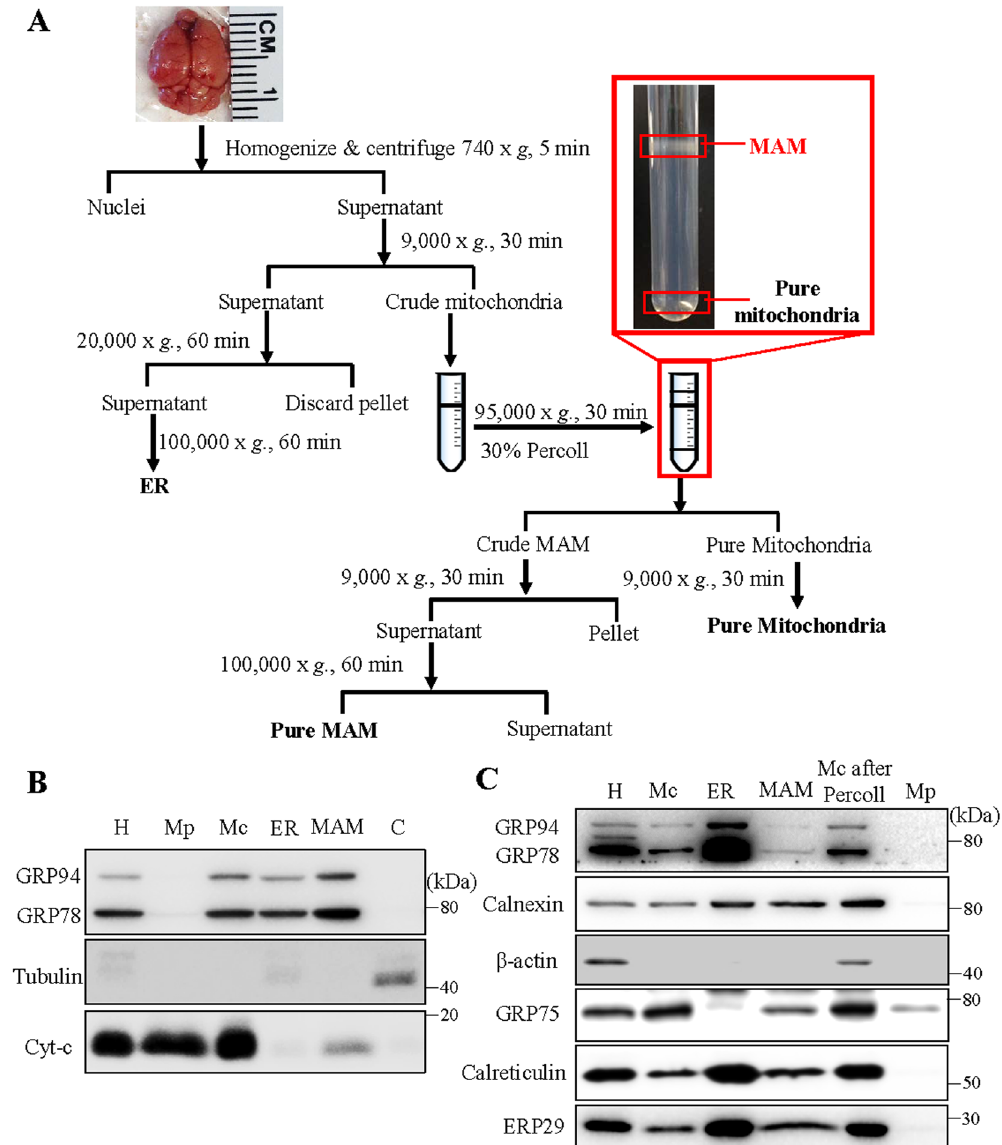
Figure 1. Schematic diagram of MAM isolation and confirmation of MAM associated proteins by western blotting. ( A ) MAM was isolated from mouse brain by applying differential centrifugations and a self- forming Percoll gradient centrifugation. Other cell organelles, as crude mitochondria, pure mitochondria and ER, were also obtained following the multiple centrifuge steps. ( B,C ) Western blot analysis of organelle markers in isolated MAM from the brain ( B ) and retina ( C ) were enriched for KDEL, and free from tubulin and cytochrome-C contamination. H: homogenate, Mp: pure mitochondria, Mc: crude mitochondria, ER: endoplasmic reticulum, MAM: ER mitochondria-associated membrane, C: cytosol, Mc after percoll: crude mitochondria after percoll gradient